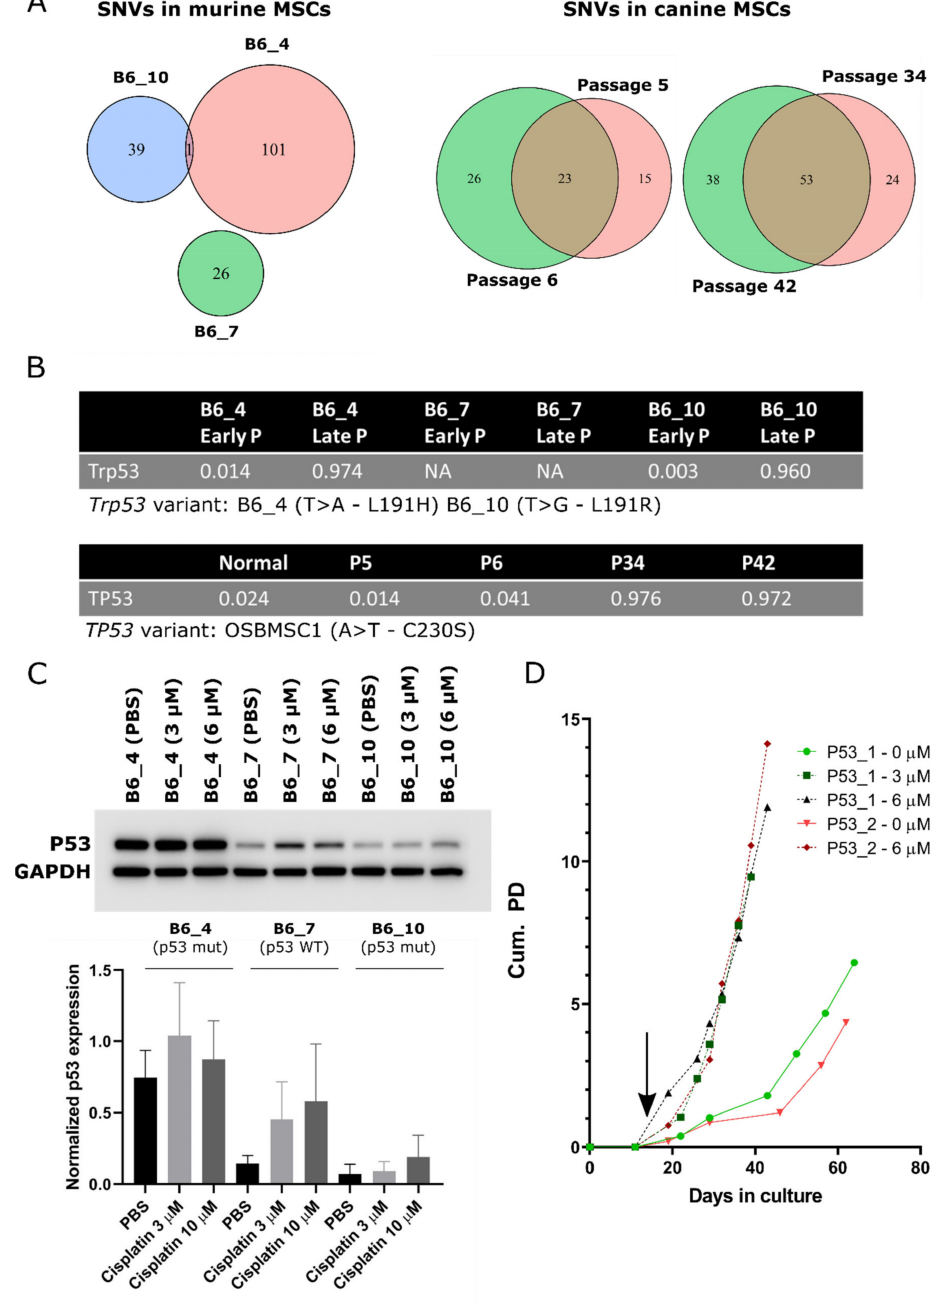
Figure 6. Point mutations in TP53/Trp53 are a common single nucleotide variant (SNV) in transformed murine and canine MSCs. Venn diagrams depicting the total number of SNVs and small indels in ( A ) late passage murine MSCs and early and late passage canine MSCs. ( B ) Single nucleotide variant in Trp53 or TP53 was the SNV with the highest allele frequency in late passage murine and canine MSCs. ( C ) Western blot showing p53 protein expression in late passage murine MSCs, treated with PBS or cisplatin (3 and 10 µ M). Murine MSCS with WT p53 (B6_7) increase p53 expression over 3-fold, whereas murine MSCS with mutant p53 (B6_4 and B6_10) increase p53 expression only 1.2–2.1 fold, indicating p53 function is partially impaired in these cells. GAPDH was used as a loading control. Quantification of relative p53 protein expression to GAPDH is depicted on the bottom panel. Statistical analysis was performed based on three independent experiments, but here only one representative blot is shown. No changes in protein expression were statistically significant. Whole blots with densitometry readings can be found in Figure S9. ( D ) Murine MSCs from Kcre/p53f mice were treated with cre-recombinase (3 or 6 µ M) at day 11 (indicated by black arrow) inducing immediate transformation, whereas non-treated MSCS transform later. At each data point, cells were trypsinized and counted to calculate cumulative population doubling (Cum.